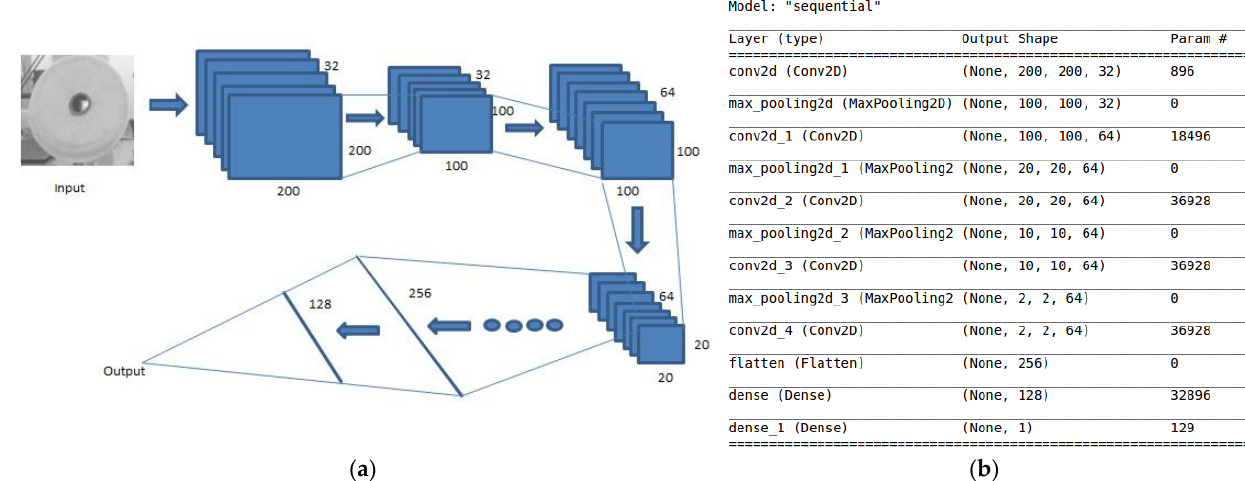
Figure 9. ( a ) Deep convolutional neural networks principles. ( b ) Model construction.